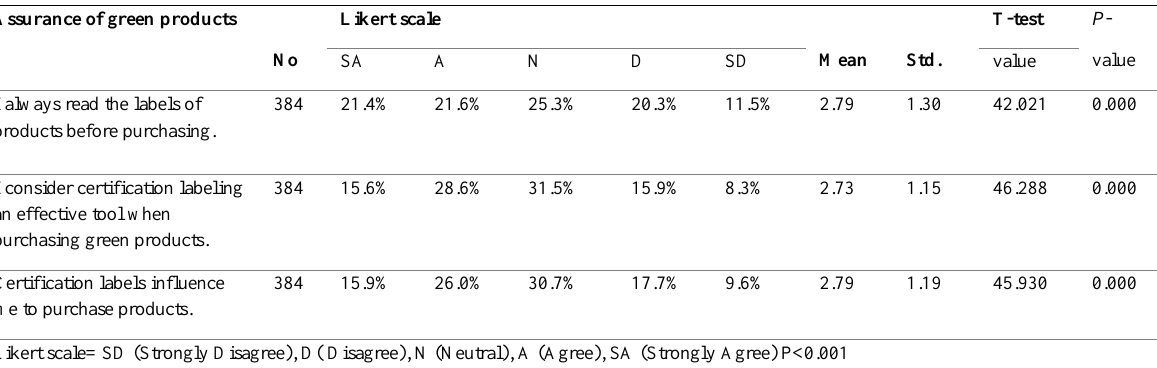
Table 6: Participants’ assurance of green products